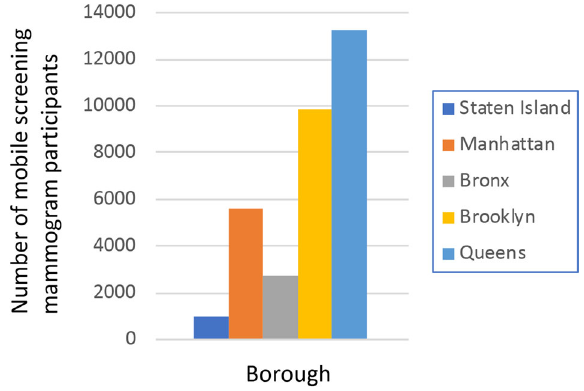
Fig. 1 Participants by borough utilizing the Mobile Mammogram Screening Program from 2014 to 2019.